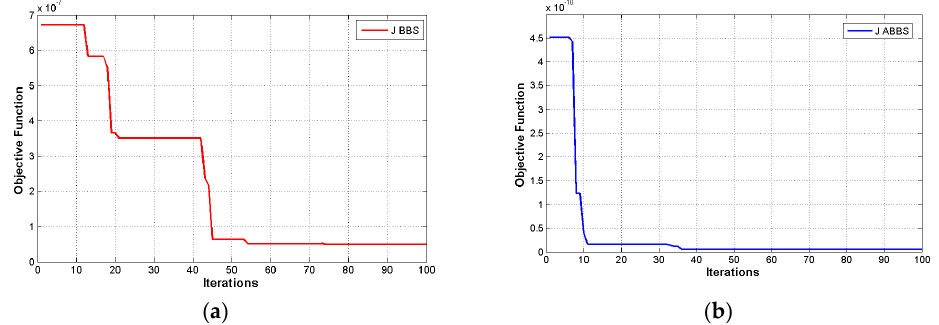
Figure 4. Evolution of the objective function versus the iterations: ( a ) conventional block-backstepping controller; ( b ) adaptive block-backstepping controller.